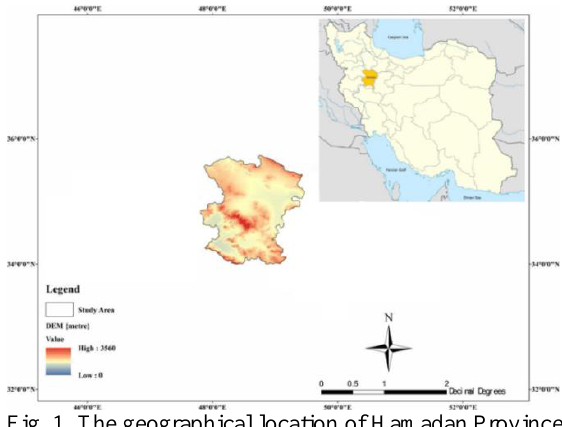
Fig. 1. The geographical location of Hamadan Province Research